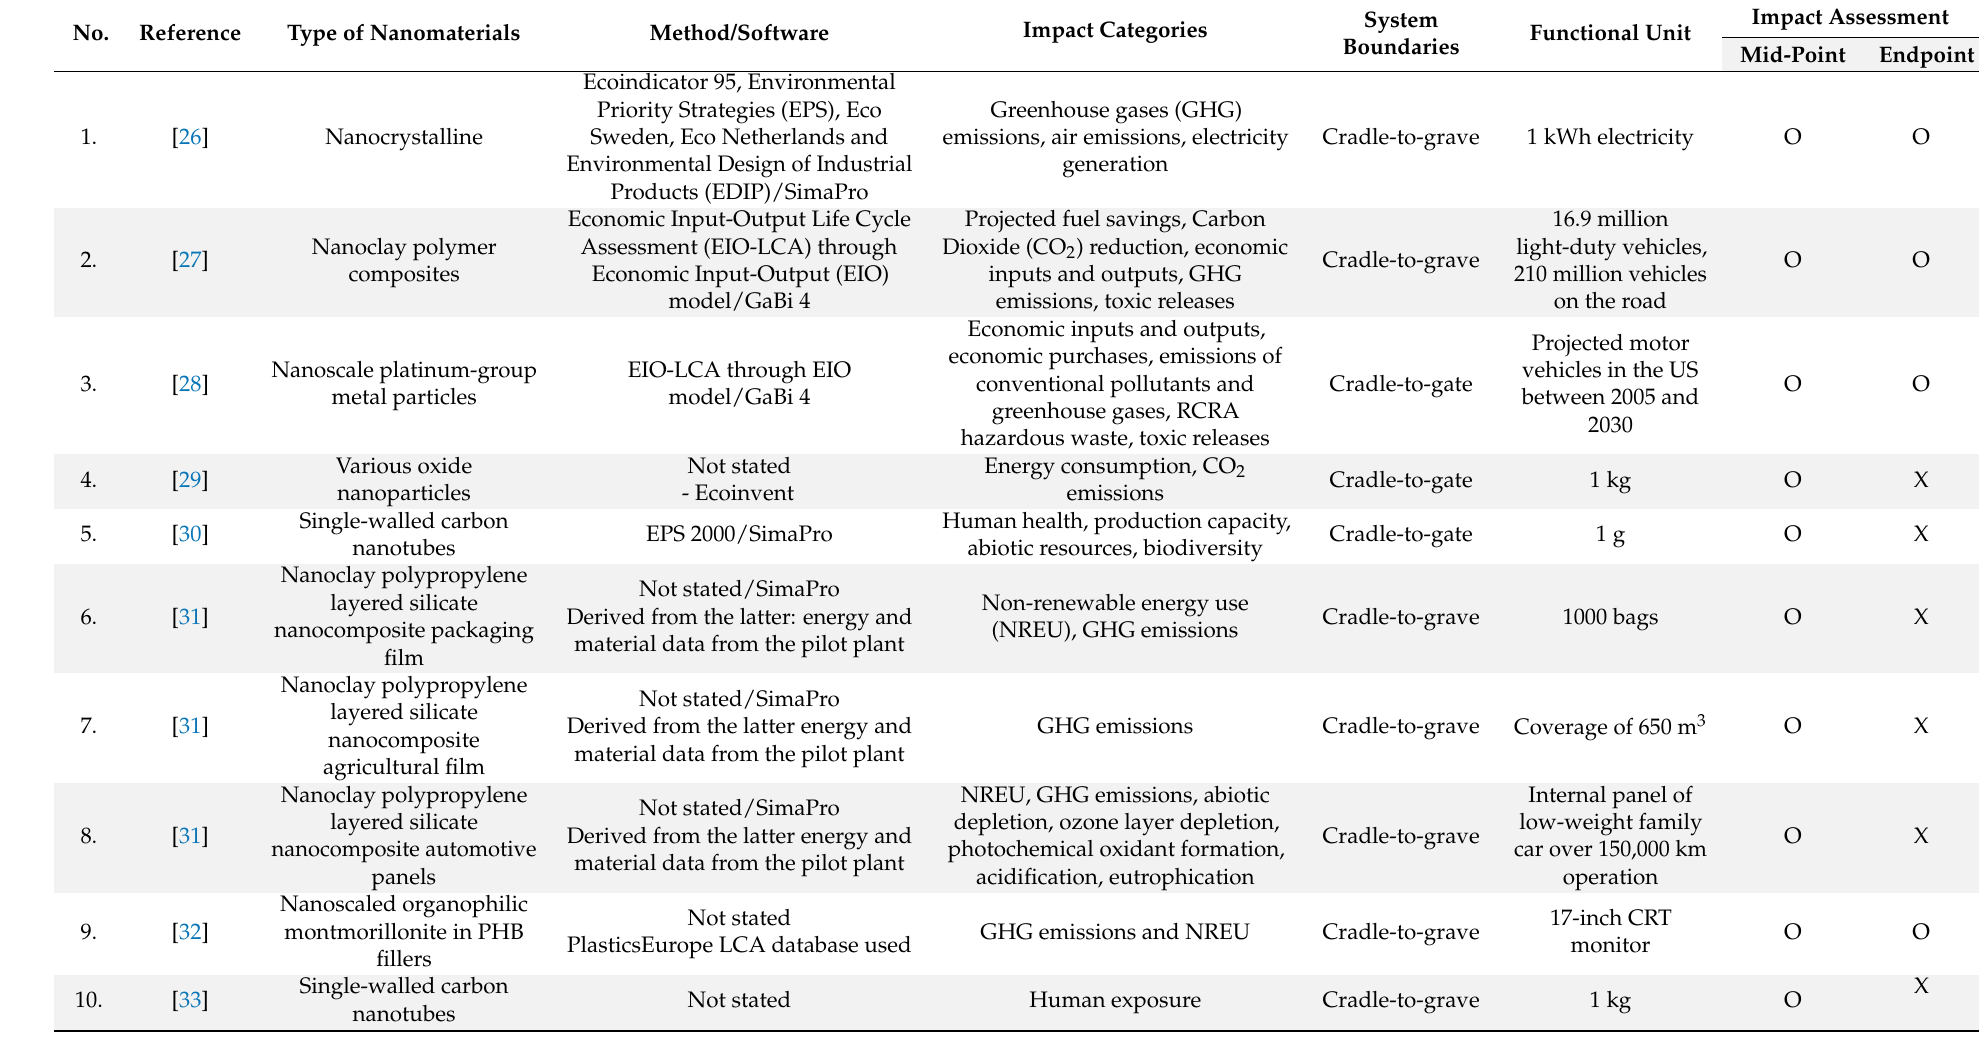
Table 1. Peer-reviewed LCA studies on